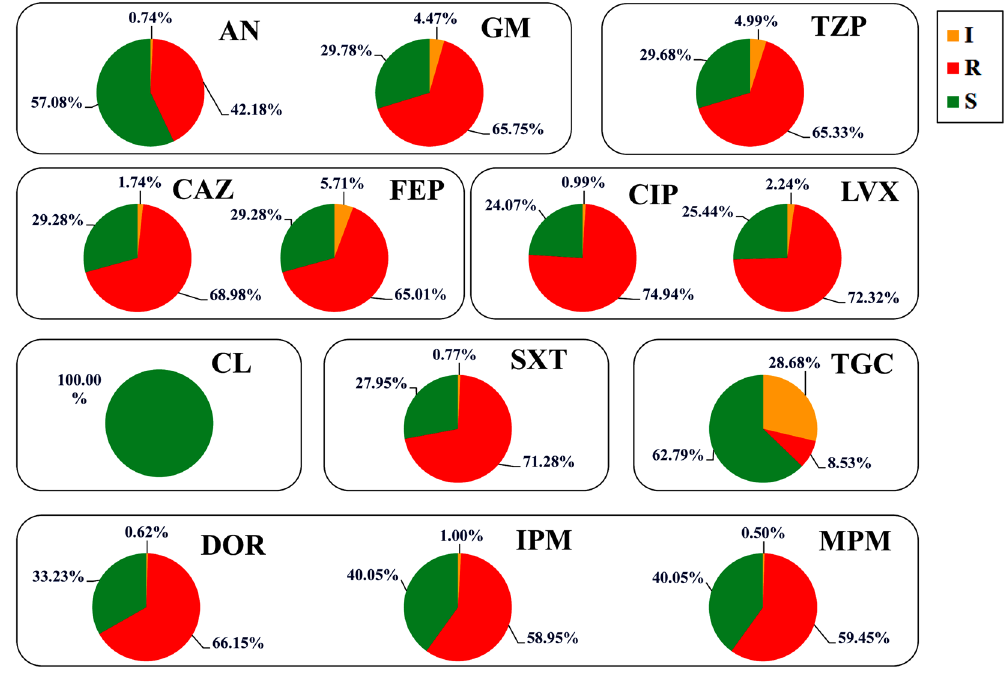
Figure 1. In vitro antibiotic susceptibilities of the clinical isolates of A. baumannii determined using the broth- dilution method: S (susceptible), R (resistance), and I (intermediate). The antibiotics in this study were divided into eight categories: (I) Aminoglycoside (amikacin and gentamicin), (II) Beta-lactam/beta-lactamase inhibitor combination (tazobactam-piperacillin), (III) Cephalosporin (ceftazidime and cefepime), (IV) Quinolone (ciprofloxacin and levofloxacin), (V) Polymyxin (colistin), (VI) Sulfonamides (baktar), (VII) Tetracycline (tigecycline) and (VIII) Carbapenem (doripenem, imipenem and